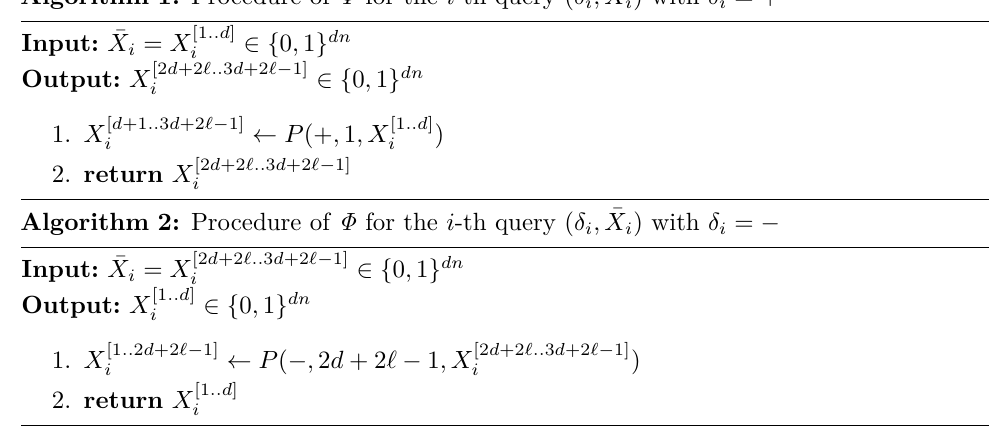
Algorithm 1: Procedure of Φ for the i -th query ( δ